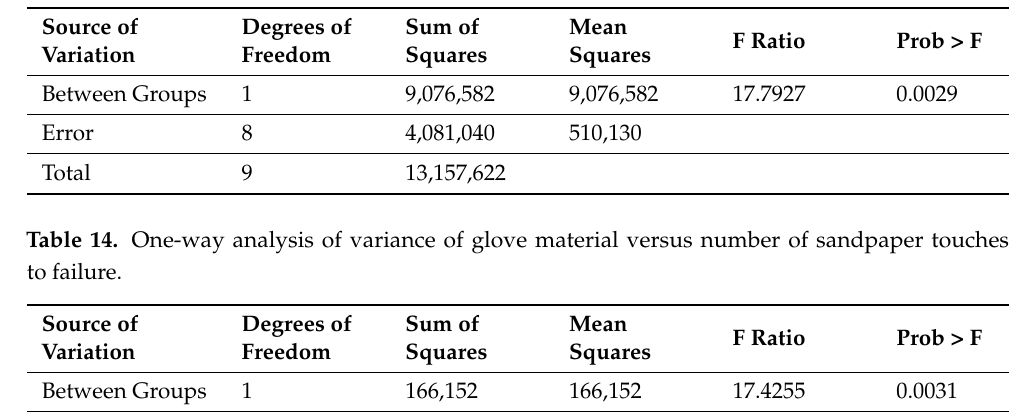
Table 13. One-way analysis of variance of glove material versus break time in seconds.